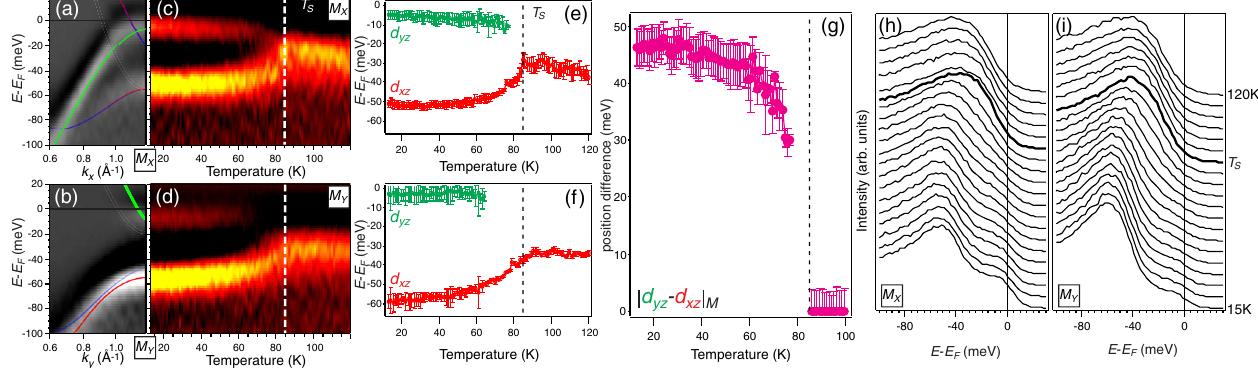
FIG. 3. Temperature evolution across the nematic transition on detwinned FeSe along Γ − M X and Γ − M Y . (a) Second energy derivative of spectra around the M X point along the a direction, taken under odd polarization at 56 eV. (b) Corresponding measurement for the M Y point along the b direction. (c) Temperature evolution of the EDC ’ s second energy derivative taken at M X . (d) Corresponding temperature evolution for the M Y point. (e) Fitted band positions for the d yz and d xz bands from (c). (f) Corresponding fits for (d). (g) The d d xz and yz band splitting as a function of the temperature extracted for (e). (h),(i) The raw EDCs at